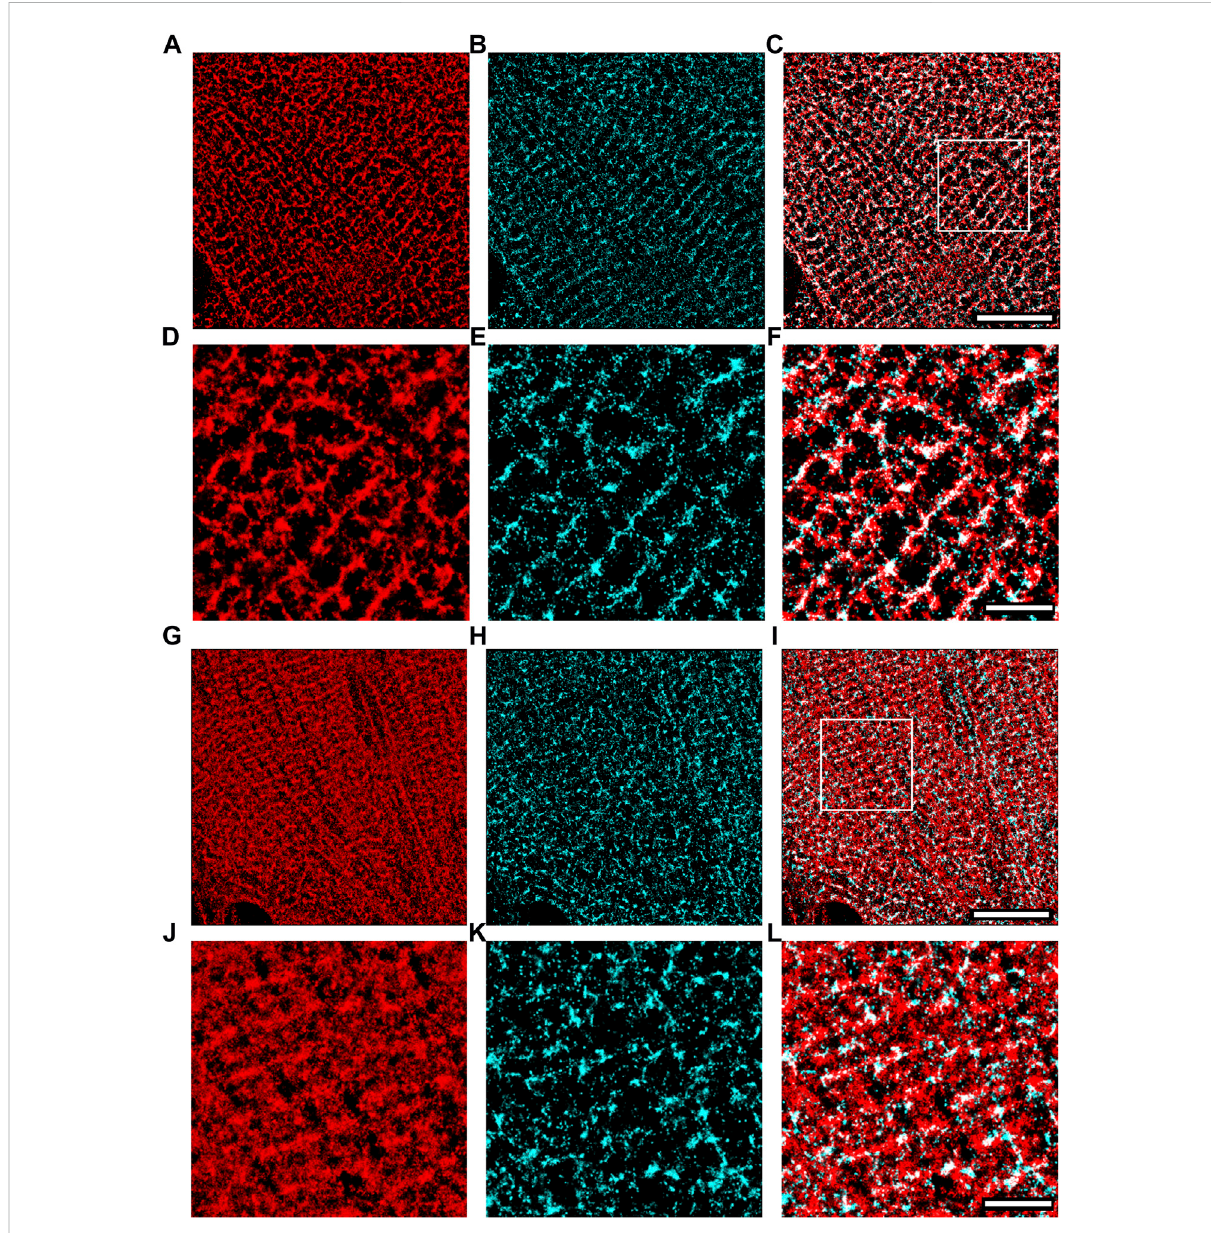
Super-resolution images of NRVMs infected with TRPC1-TagBFP2 (A – F) and TagBFP2 (G – L) . TRPC1-TagBFP2 cells exhibit a striated arrangementofboth (A) TagBFP2and (B) SERCA2 fl uorescence. (C) ColocalizationofTagBFP2andSERCA2inTRPC1-TagBFP2cellsishigh,shownin white. (D – F) Zoomed in region from (A – C) depicted by white box in (C) . (G) TagBFP2 fl uorescence in control cells is distributed throughout the cell, with more dense concentration near sarcomere structures. (H) SERCA2 fl uorescence in TagBFP2 control cells follows a network, with (I) minimal colocalization with TagBFP2. (J – L) Zoomed in region from (G – I) depicted by white box in (I) . Scale bars in (C,I) = 10 µm. Scale bars in (F,L) = 3